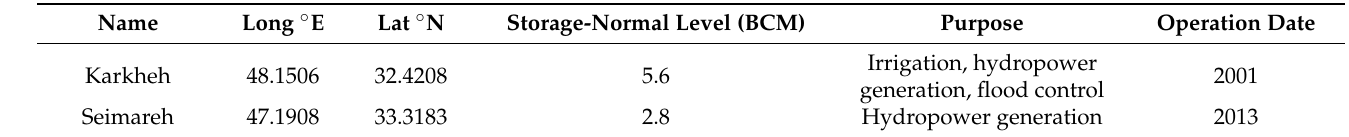
Table A1. The KRB’s major dams of the KRB.